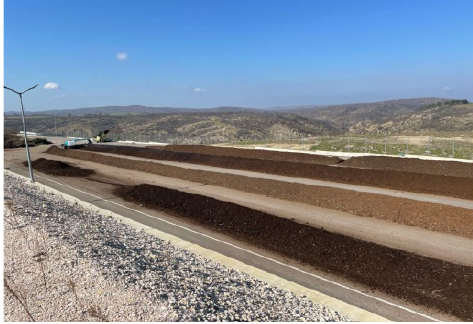
Figure 4. Compost windrows in Area No 1.